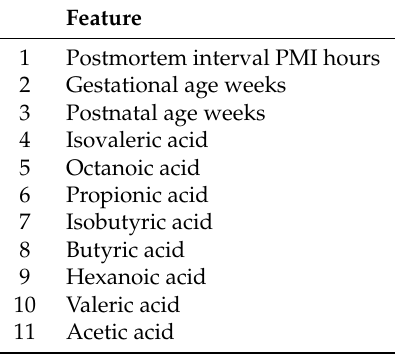
Table 1. Features contained in the “short chain fatty acids (SCFAs) profile in babies dying from sudden infant death syndrome (SIDS)”